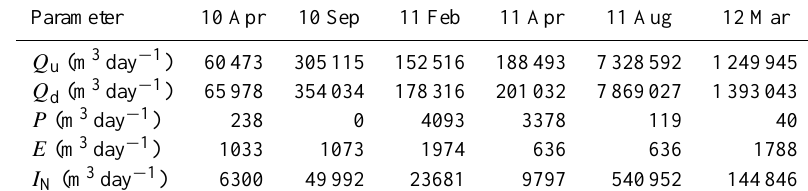
Table 2. Parameters used for calculating the net groundwater flux ( I ) by differential flow gauging using Eq. (1).